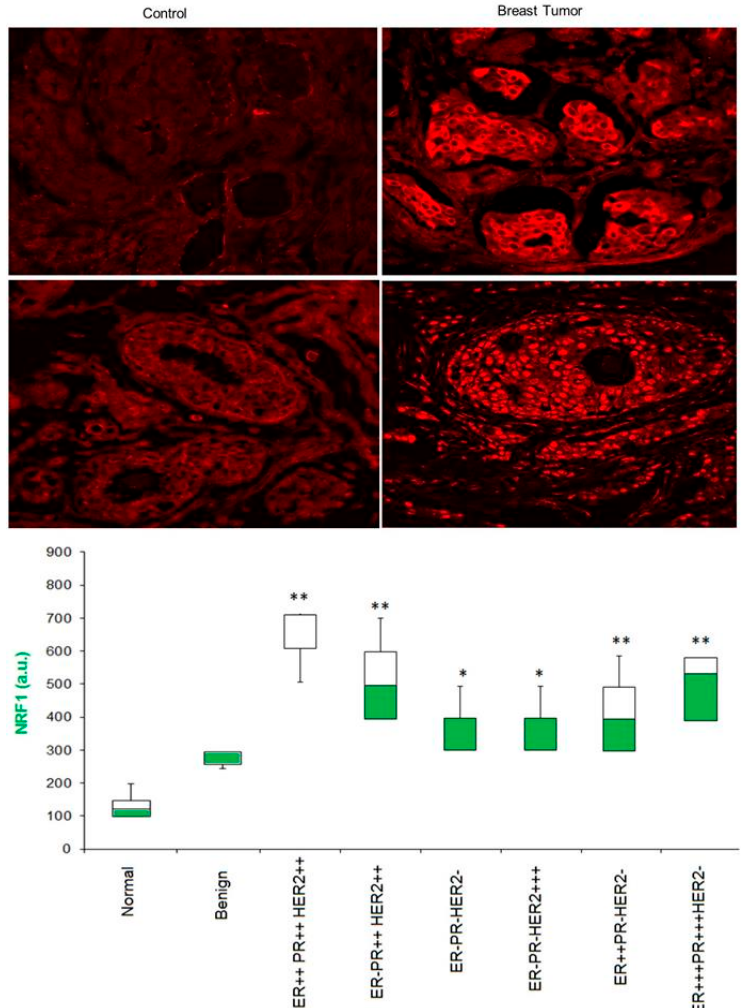
Figure 5. The representative confocal immunofluorescence microscopy image of NRF1 protein expression in breast cancer and box plot showing relative quantitative value of NRF1 intensity in different stages of breast cancer (6 normal, 6 benign, and 138 malignant samples probed with NRF1 antibodies conjugated with Texas Red secondary antibodies ** p < 0.01 and * p < 0.05).